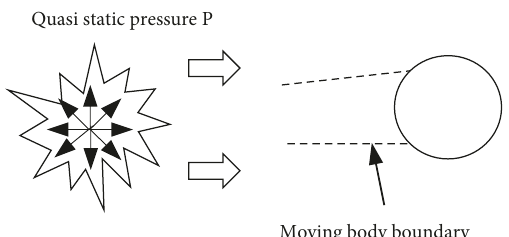
Figure 13: Control the movement boundary of coal inside the hole.